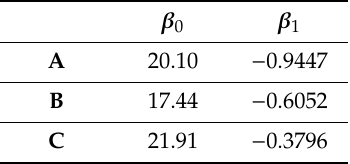
Figure 7. Borehole resistance shape factors for U-tube. Table 3. Coe ffi cients for the borehole resistance shape factor.